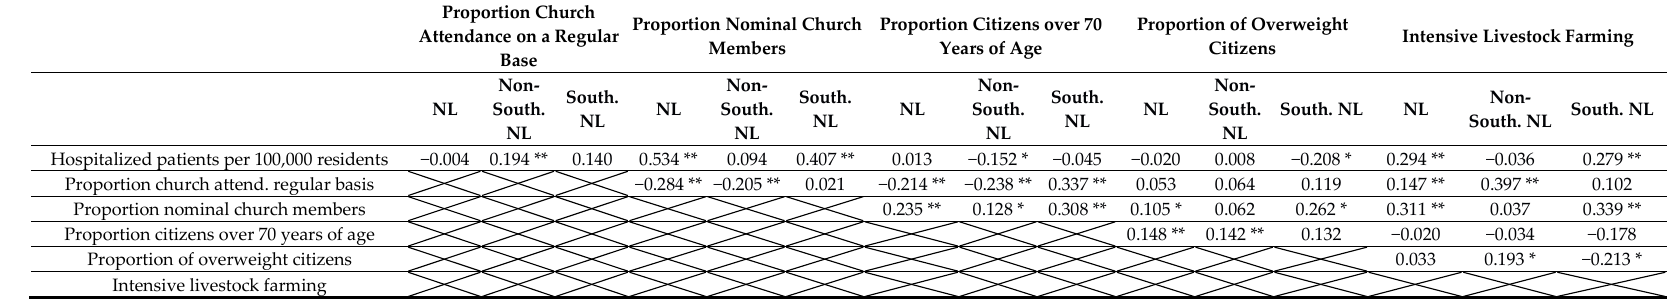
Table 1. Correlations (Pearson’s r ).